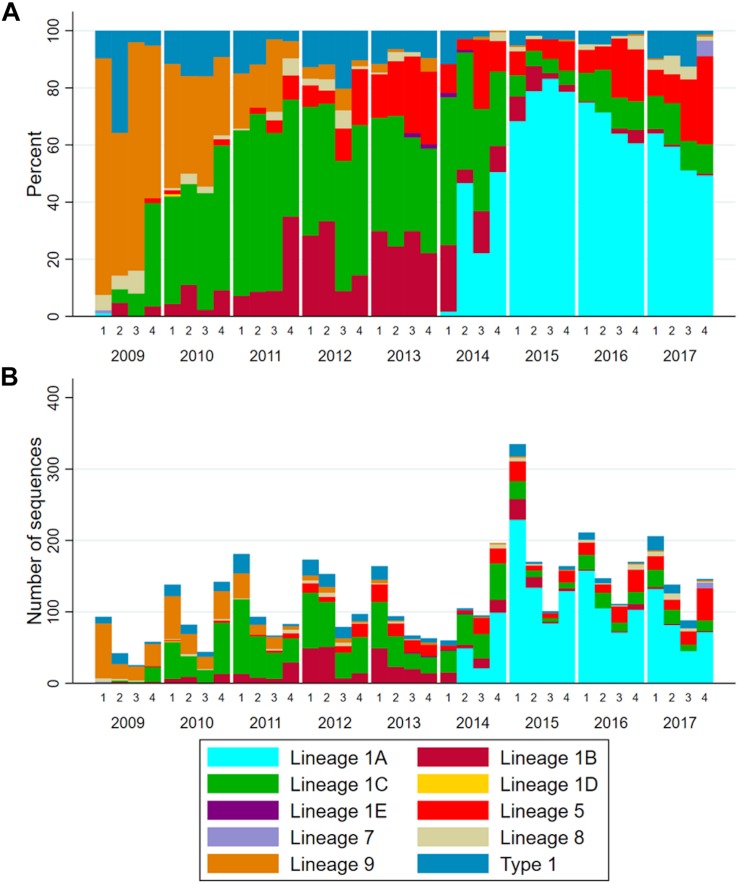
(A) Stacked bar chart of the relative frequency and (B) number of ORF5 sequences according to lineages over years and quarters.